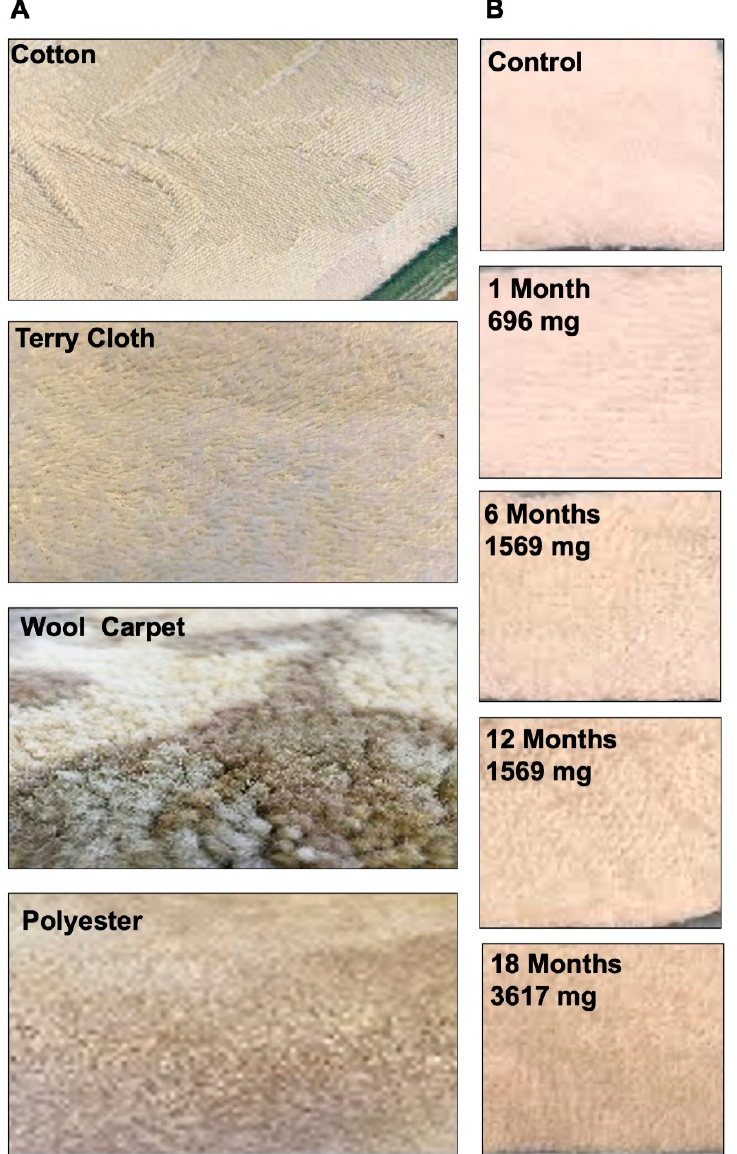
Figure 1. Common household fabrics exposed to thirdhand smoke (THS). ( A ) Cotton, terry cloth, wool carpet, and polyester were exposed to THS. All samples in A are unexposed fabrics. ( B ) Terry cloth exposed to different concentrations (mg) of particulate material from cigarette smoke at 1, 6, 12, and 18 months.